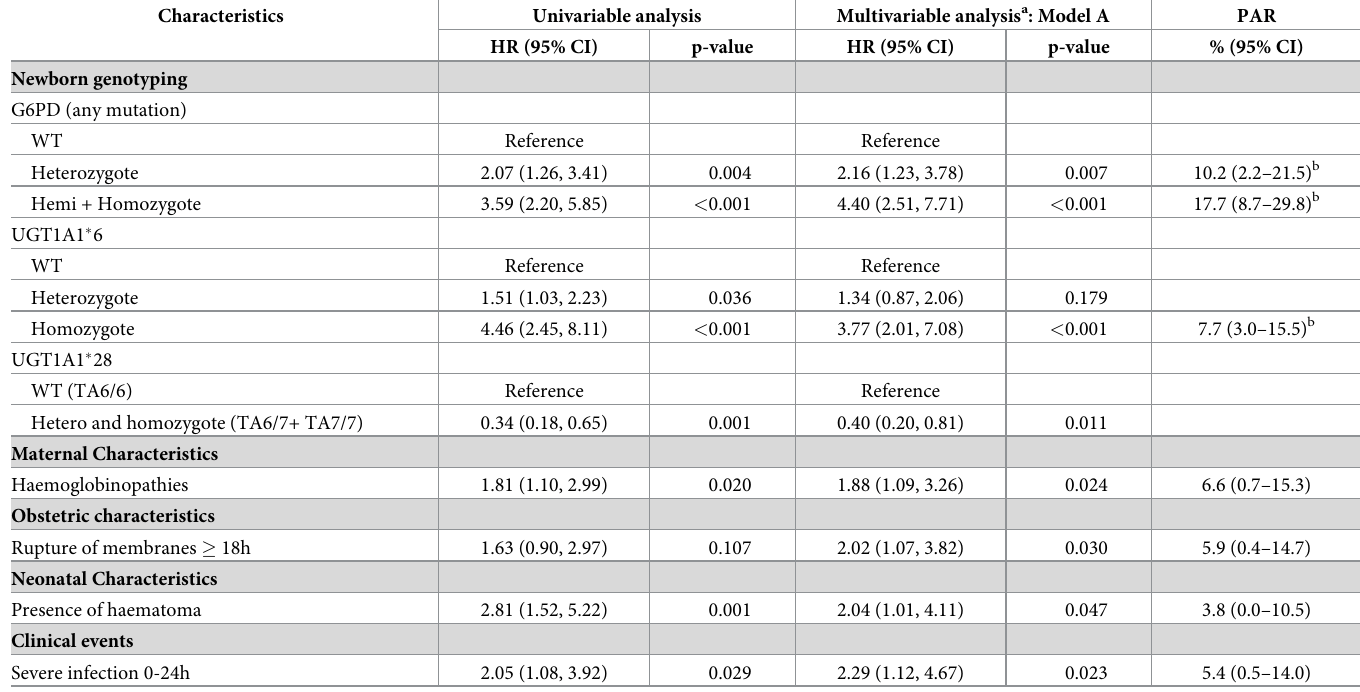
Table 4. Late Neonatal hyperbilirubinaemia (NH) in neonates with EGA � 38 weeks: Uni- and multivariable analysis of genetic factors and other significant risk fac- tors using a mixed effects Cox proportional hazard model clustering by site among neonates who developed NH late (49–168 hours) and neonates who did not develop NH in the first week of